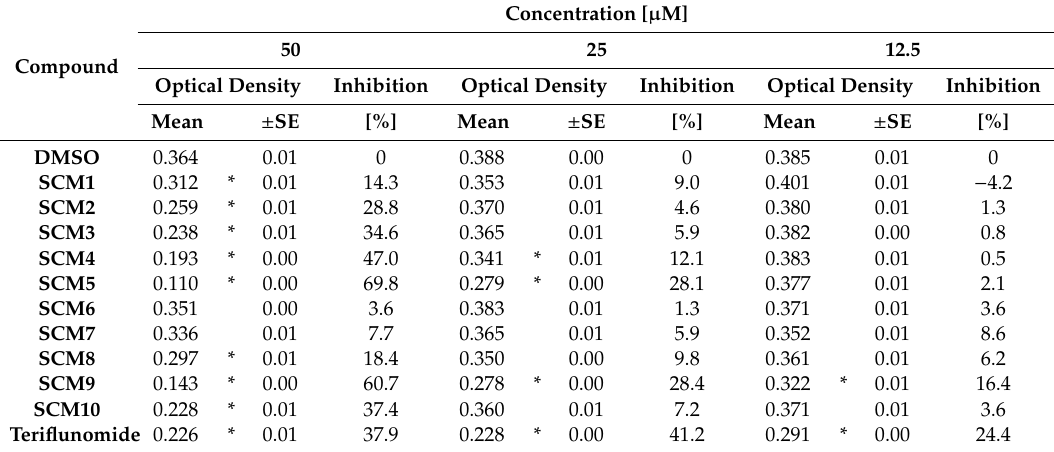
Table 2. The effects of the compounds on PHA-induced proliferation of PBMC. The compounds were added to the cultures at concentrations of 50, 25 and 12.5 µM. The proliferative response of the cells in 72 h culture was determined by colorimetric MTT method. Teriflunomide was used as a reference drug. The results are presented as the OD (Optical Density) values from quadruplicate determinations (mean ±SE).